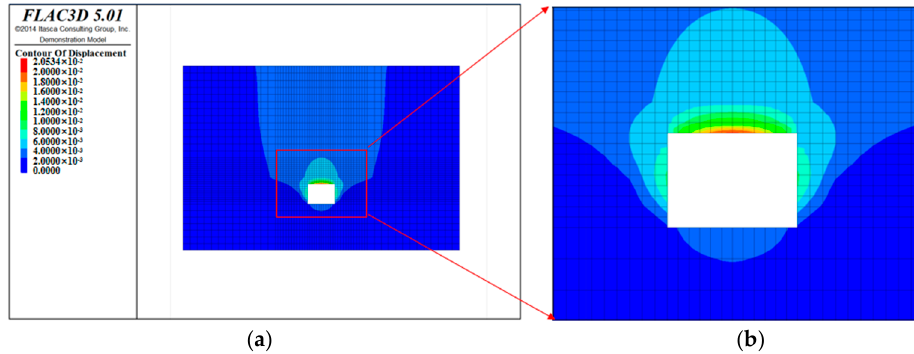
Figure 8. Cloud chart of surrounding rock deformation. ( a ) Overall picture; ( b ) Enlarged picture.